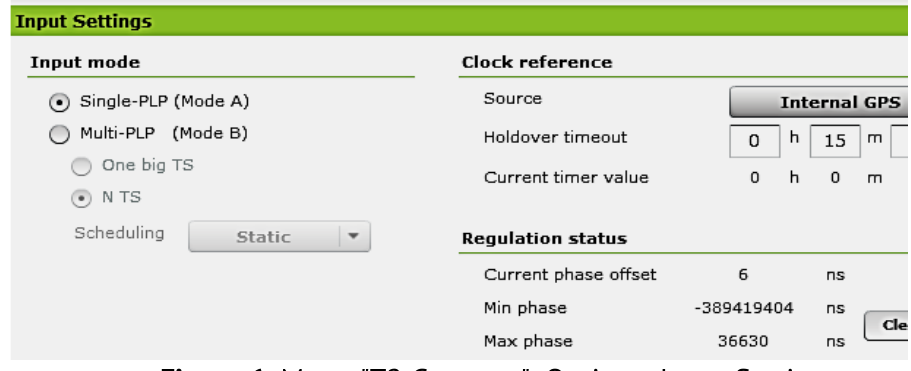
Figure 6. Menu "T2 Gateway": Option - Input